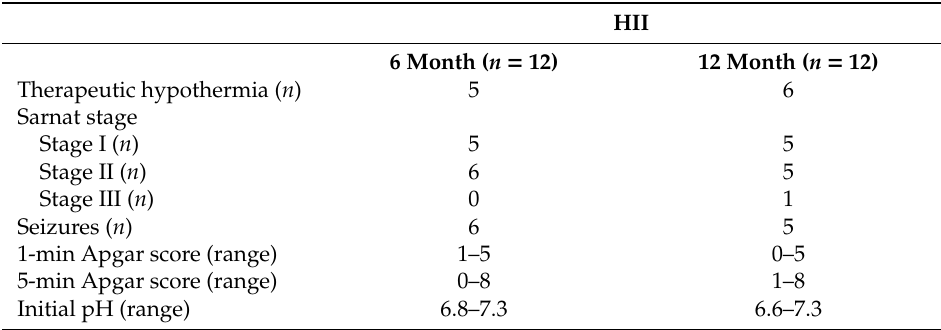
Table 1. HII severity of